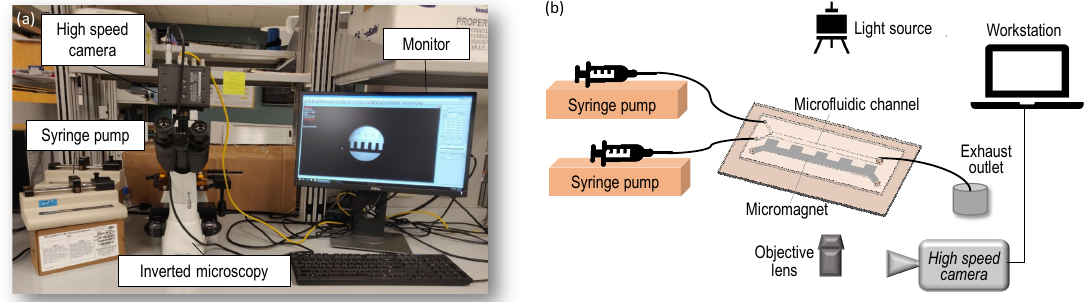
Figure 3. ( a ) Main components of experimental setup: high speed camera, syringe pump, inverted microscopy platform, and computer; ( b ) Schematic of the experimental system for micromixing between ferrofluid and bu ff er